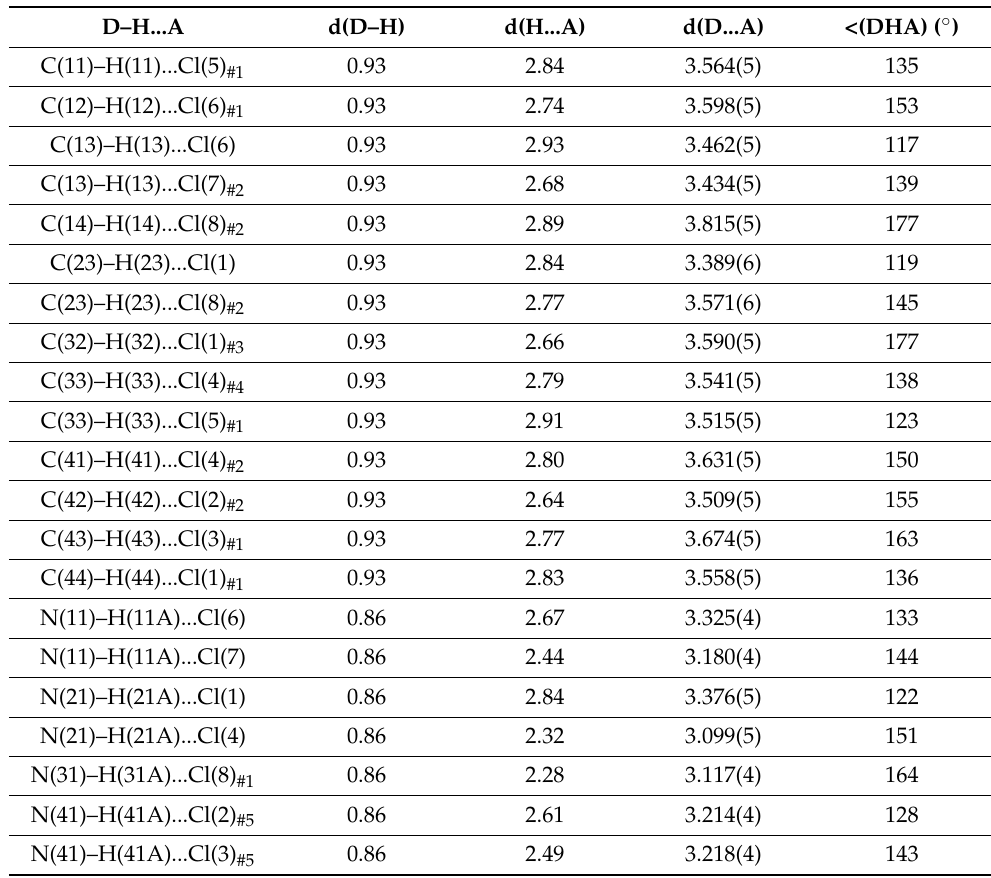
Table 3. Hydrogen bonds of (C 9 H 14 N) 2 [CuCl 4 ].